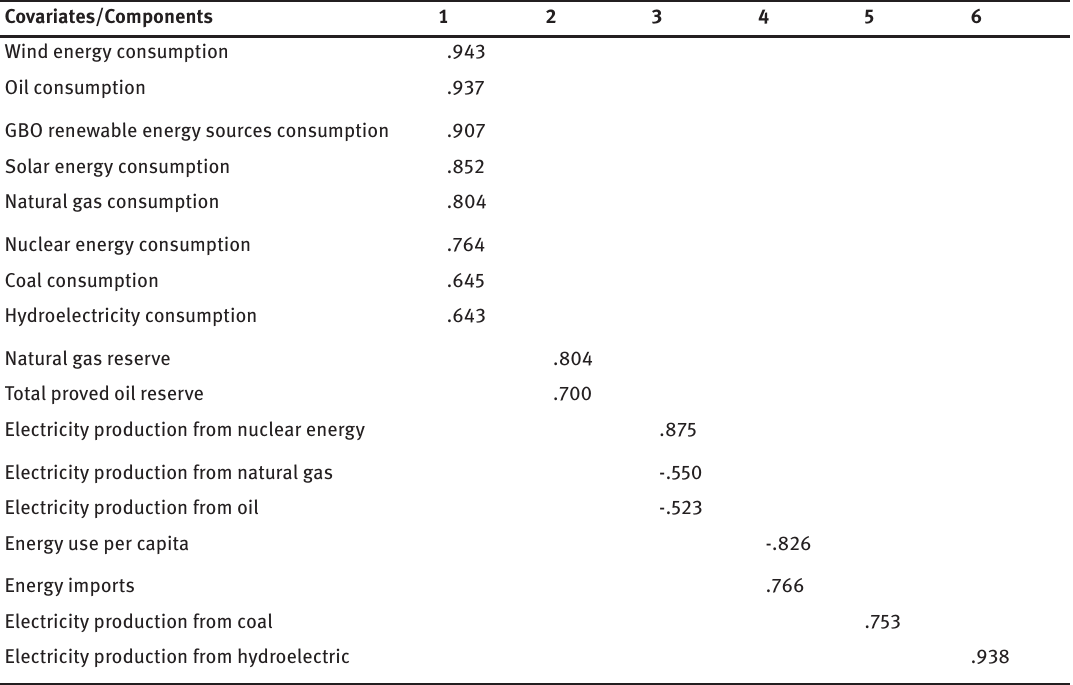
Table 4: Rotated component matrix between the covariates and the components in PCA for the world energy security data.